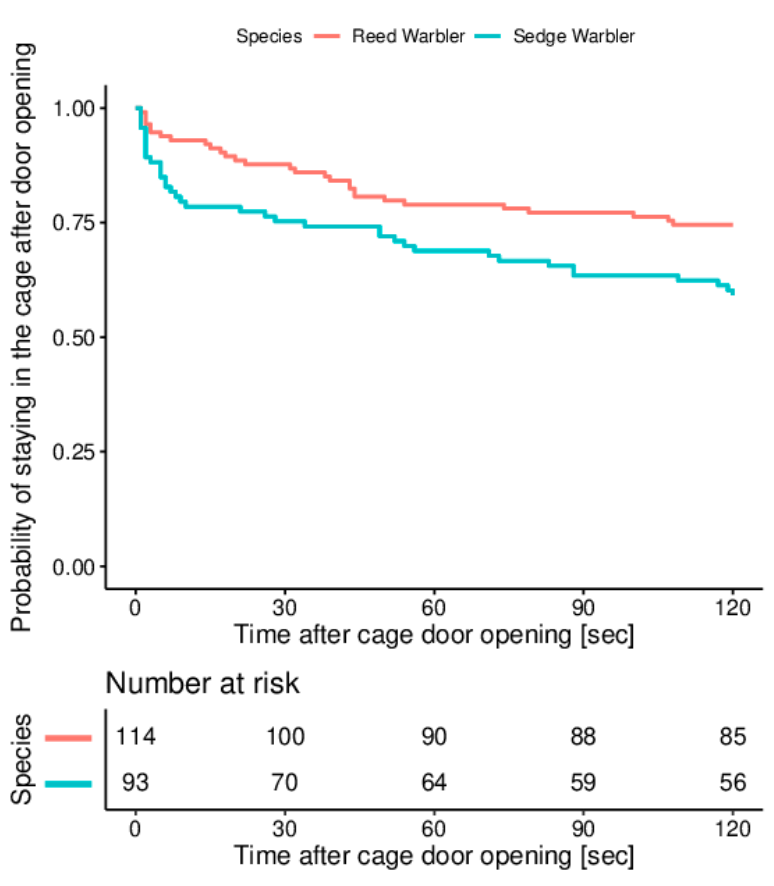
Figure 3. Kaplan-Meier survival curves for reed and sedge warblers tested during the autumn migration at the stop-over site at “Druzno Lake” reserve.